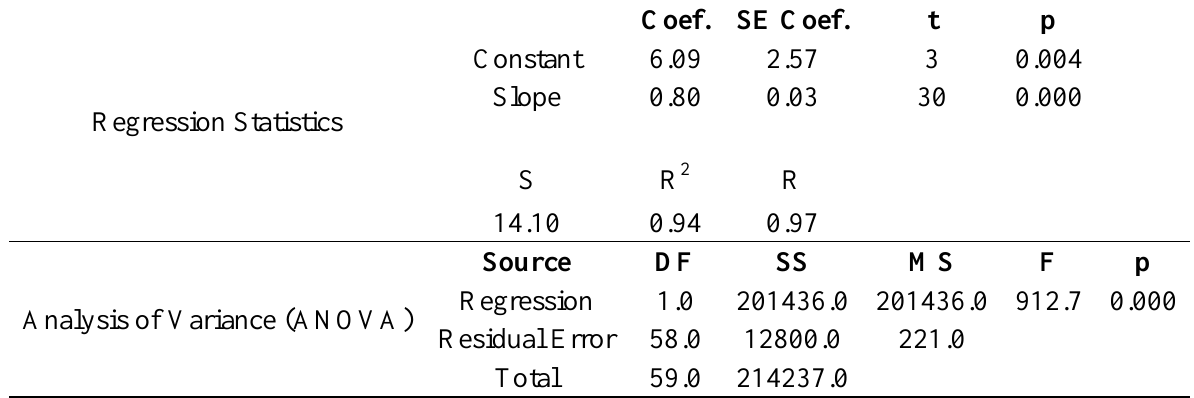
Table S1 . Regression statistics between TRMM and in-situ rainfall estimates.